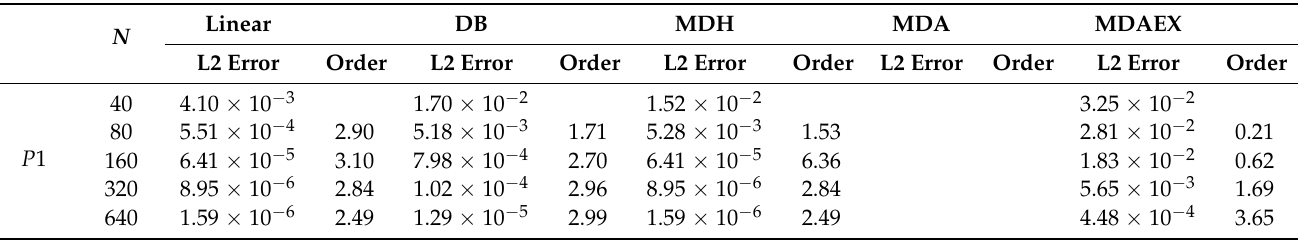
Table 2. L 2 errors and accuracy orders of shock-capturing models for the two-dimensional isentropic vortex